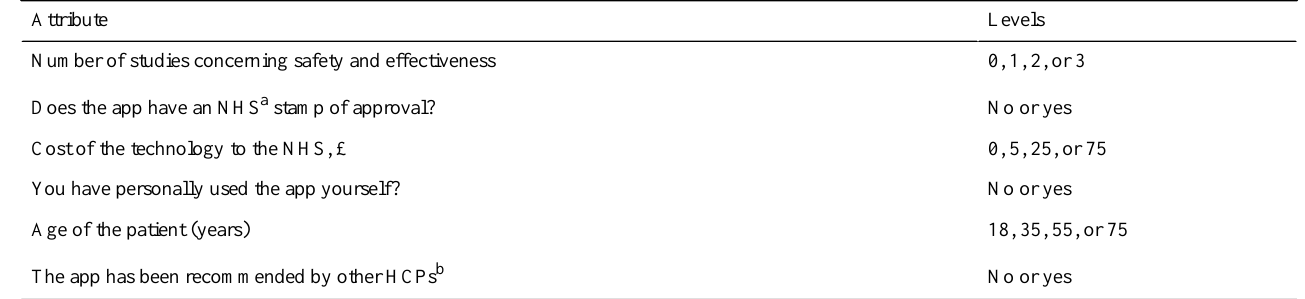
Table 1. Attributes and levels of the discrete choice